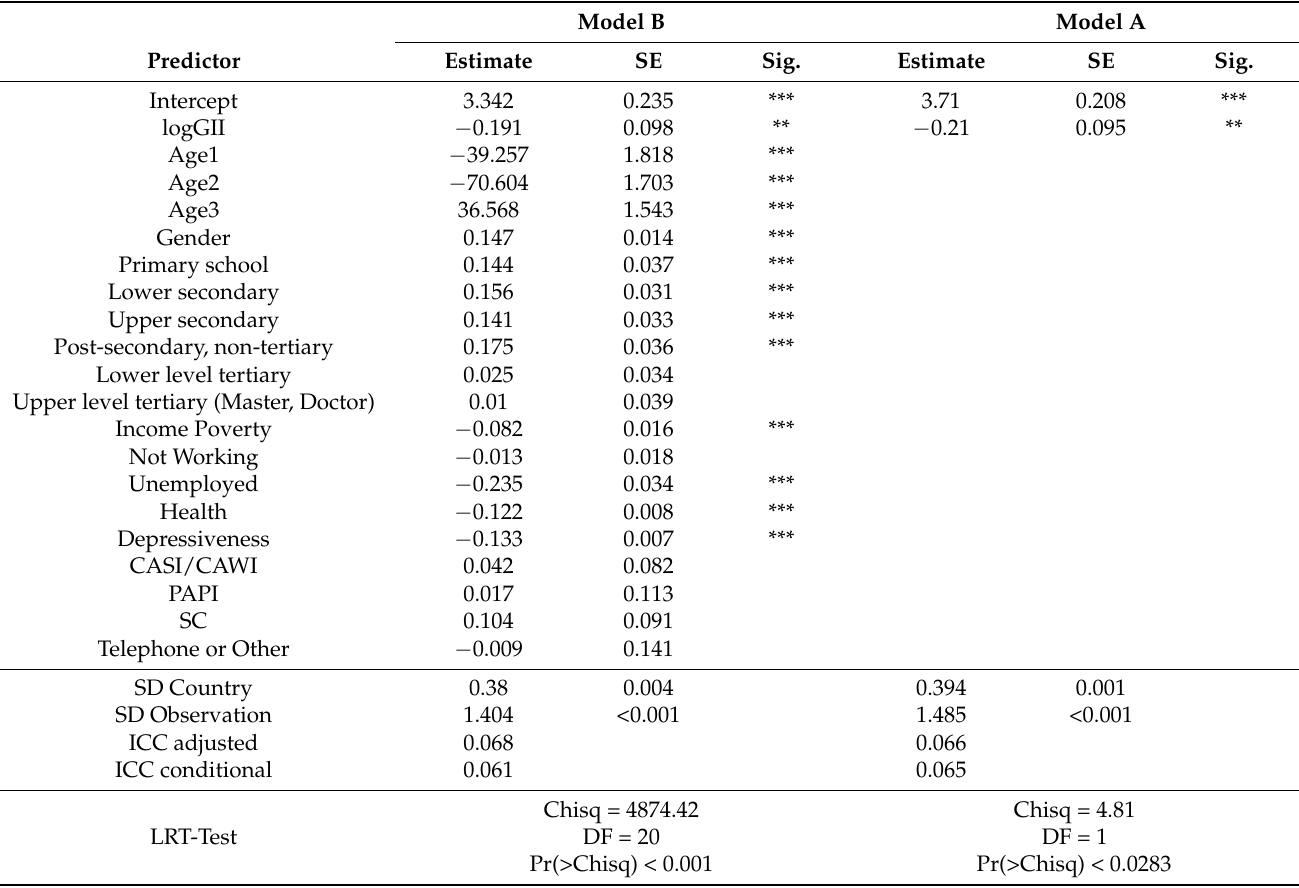
Table A4. Multilevel linear regressions of the effect of GII on SNI emo (Full Table 4).